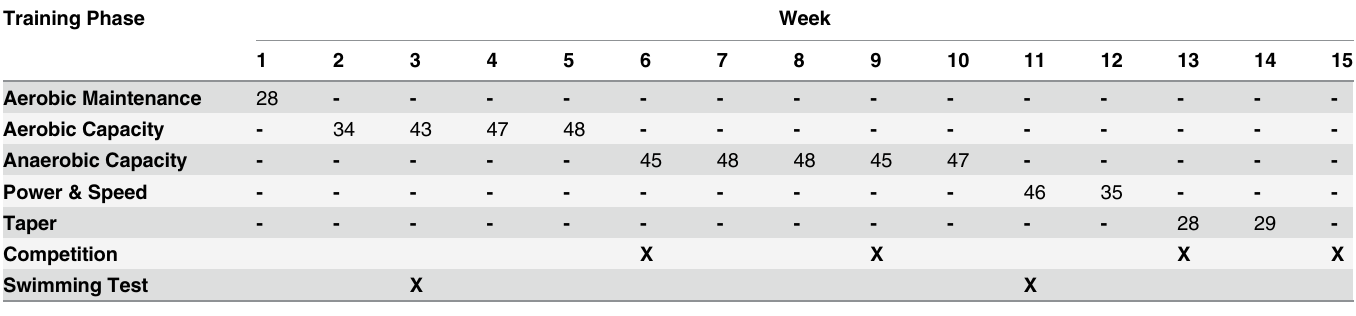
Table 2. Average weekly kilometres completed during the 14 week monitoring